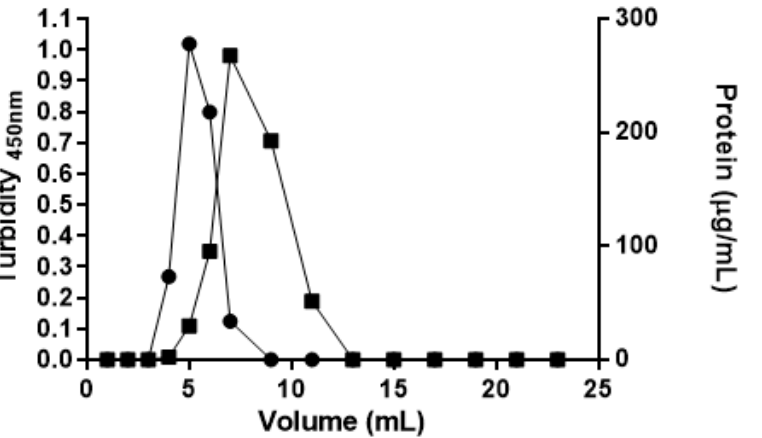
Figure 3. Sephadex G-200 column chromatography elution profile for the purification of ASP-enzymosomes. ( ● ) Liposomes turbidity at 450 nm; ( ■ ) Protein concentration measured by Lowry method. The results presented are from one representative experiment, among the three independent experiments performed.